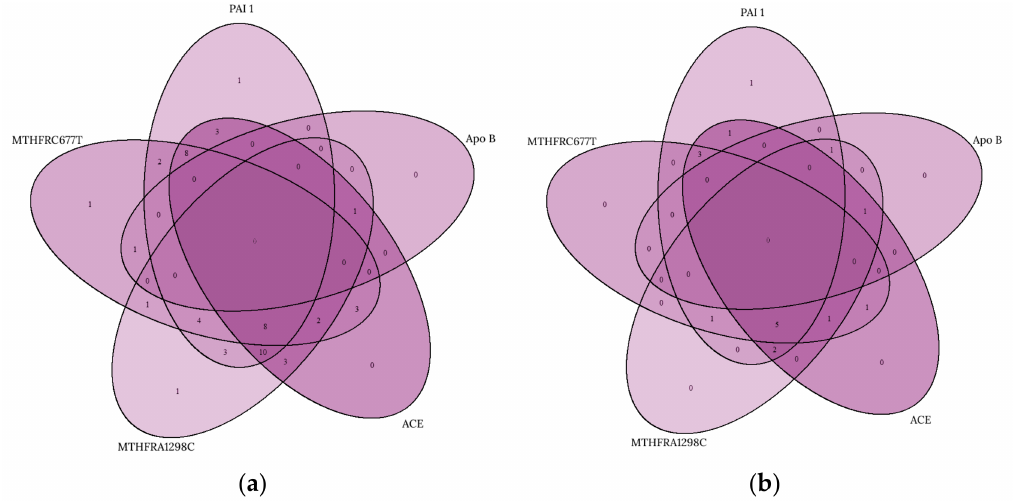
Figure 2. Multiplicity of the studied polymorphisms in the FH group ( a ) and control group ( b ).